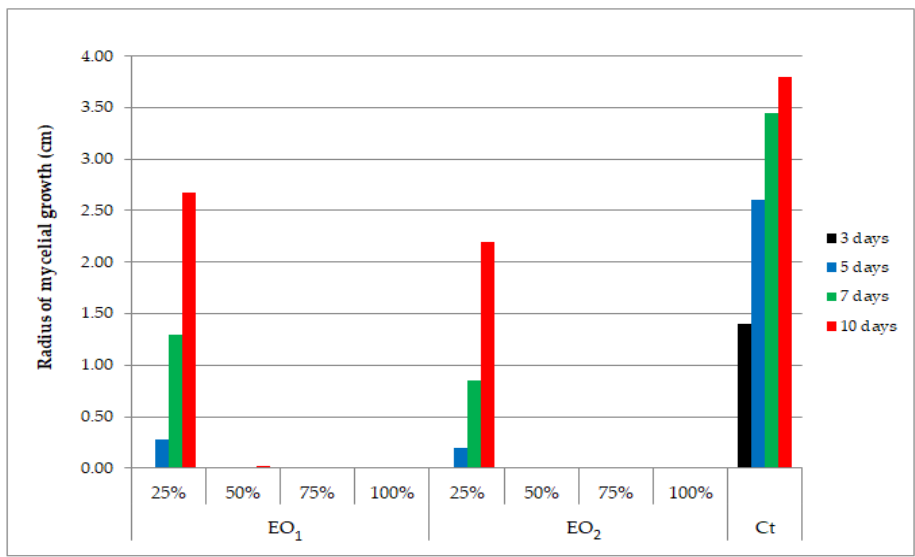
Figure 11. Fungal cell lysis of Botrytis cinerea when exposed to EO 2 basil at C 4 = 25% in the emulsion (the arrow indicates cytoplasm leaks). Among the three volatile compounds tested (Table 6), eugenol completely inhibited fungal growth in all tested concentrations (25% and higher). As the complete inhibition was maintained not only in the first 10 days of cultivation, but also after a prolonged in- cubation, it can be concluded that eugenol has a fungicidal effect on the gray mold. Com- plete fungal growth inhibition was obtained also when using linalool in 50% and higher concentrations. Although, at C 4 = 25% and 40 µL dose/plate, linalool revealed only 12.17% fungal inhibition efficacy. However, estragole revealed a poor antifungal effect, of 25.99% inhibition efficacy, even when tested undiluted, in 40 µL dose/plate.